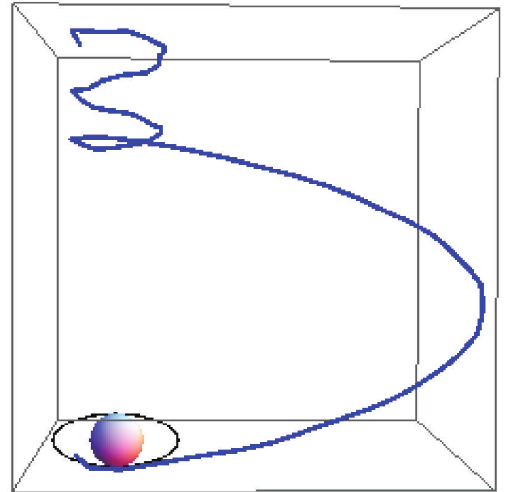
Figure 12: Trajectory of the escaping particle around RN-BH, for 𝑏 = 1.5 , ℓ = 1 , E = 2 , 𝜌[0] = 1 .